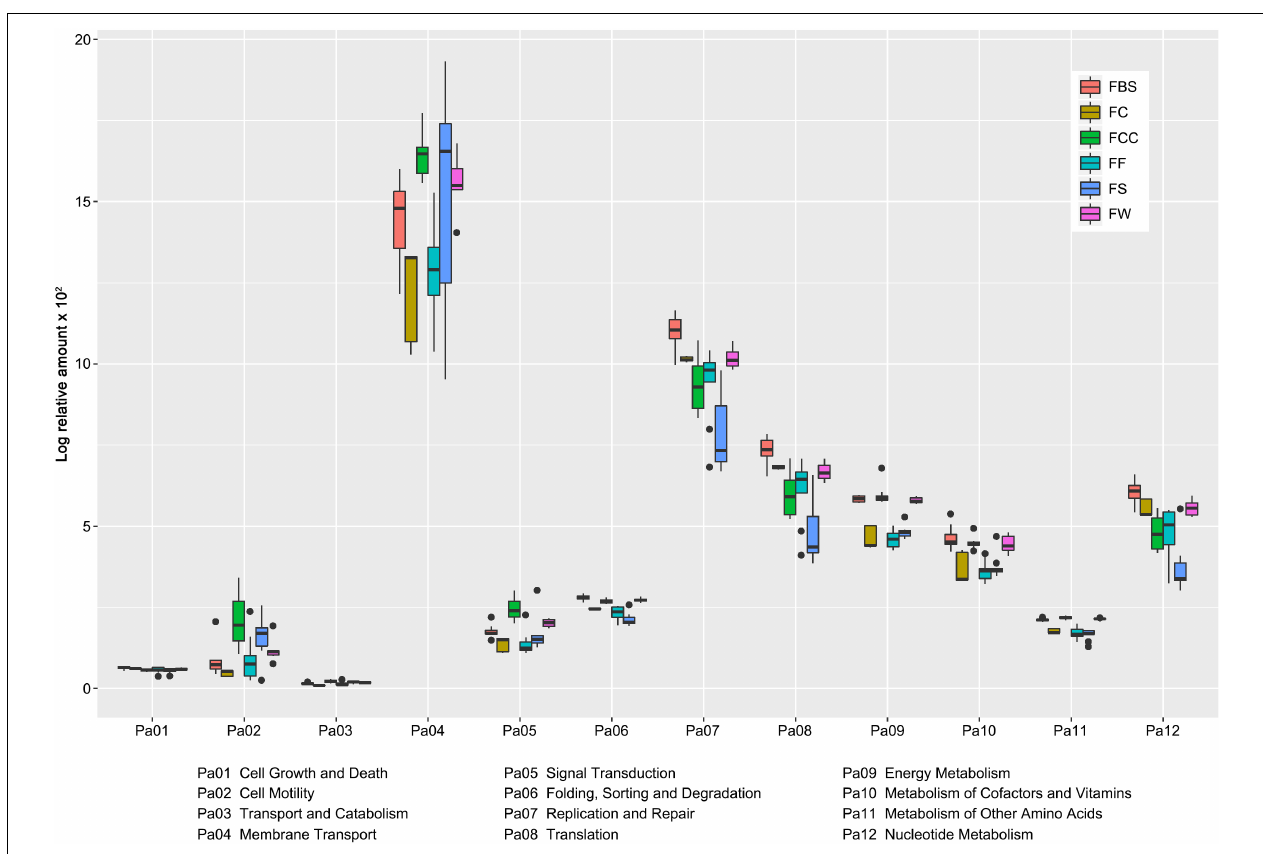
FIGURE 4 | Abundance of metabolic pathways that showed differences ( P < 0.05) among the samples was compared by using PICRUSt.